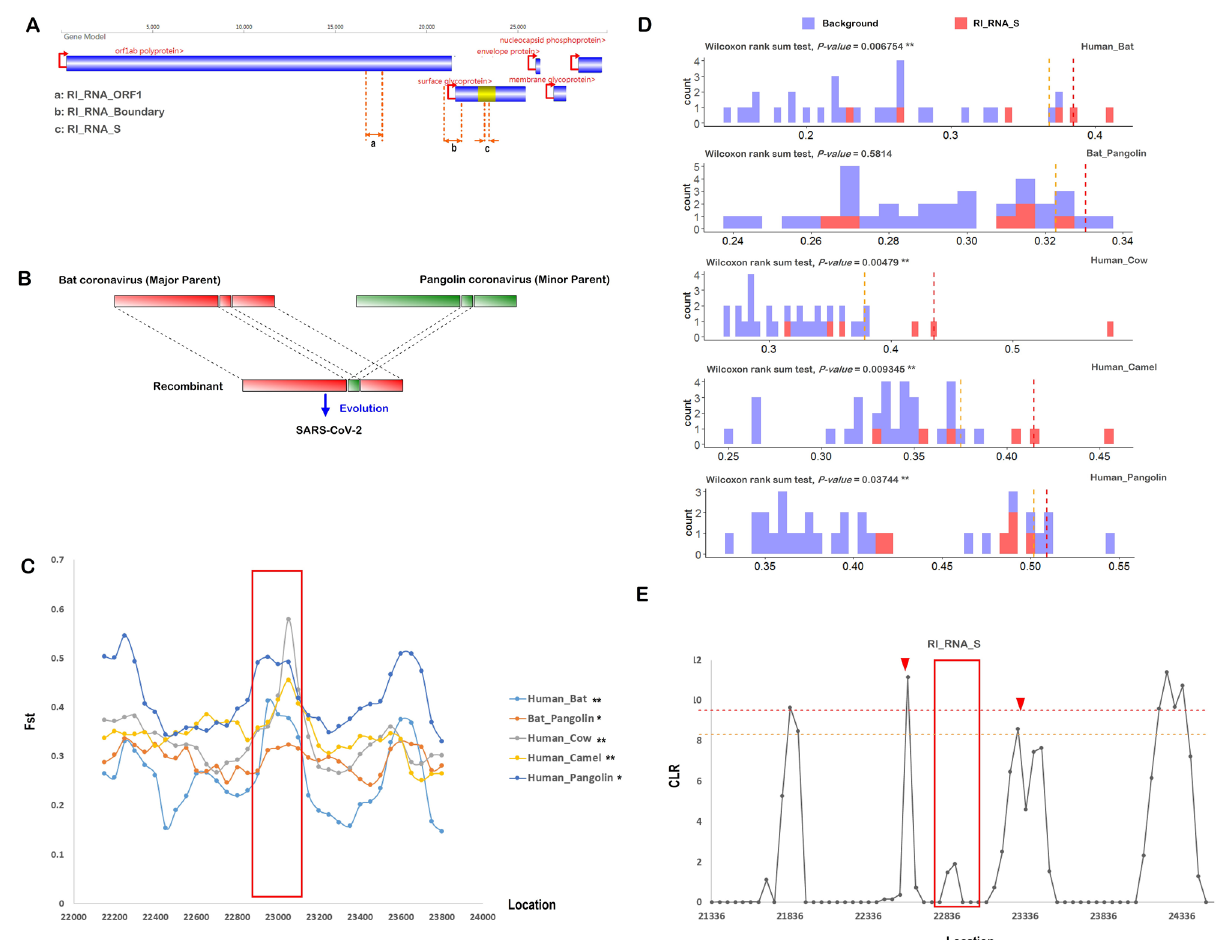
Figure 2. A sketch of the three recombination events and population genetic analysis results for RI_RNA_S. ( A ) Coordinate positions or positions of three recombinationally integrated RNA regions (indicated out by orange dotted lines) in the genome of SARS-CoV-2 (MN908947), with major proteins marked. ‘a’, ’b’ and ‘c’ refer to RI_RNA_ORF1, RI_RNA_Boundary and RI_RNA_S, respectively. Yellow represents the RBD in S protein. Red arrows with lines indicate the direction of transcription in SARS-CoV-2. ( B ) Diagram depicting a possible origin of SARS-CoV-2. ( C ) Snapshot of sliding window analysis of Fst (between coronaviruses from human and bat, human and pangolin, human and camel, human and cow as well as bat and pangolin). The region of RI_RNA_S is marked by a red rectangle. In the legend to the right, peaks at RI_RNA_S that are statistically significant (with values higher than the 0.05 threshold in the nearby region) are marked with ‘**’, and those with weak significance (with values higher than the 0.1 threshold in the nearby region) are marked with ‘*’. ( D ) Comparison of the distributions of Fst in RI_NA_S (red) and the nearby region (background, blue). Pairs of distributions in RI_NA_S and the flanking region were compared by the Wilcoxon rank sum test and a P -value is given. Vertical dashed lines denote the 0.05 cutoff (red) and 0.1 cutoff (orange) of the background distribution. ( E ) Sliding window analysis of CLRs with RI_RNA_S marked by a red rectangle. The result was generated using SARS-CoV-2 strains collected in April. Red triangles denote the two CLR peaks surrounding RI_RNA_S. The two peaks are significant or weakly significant if using the region nearby (from 21,000 to 25,000 bp) as a background, whose top 0.05 cutoff is denoted by a red dashed line and top 0.1 cutoff is denoted by an orange dashed